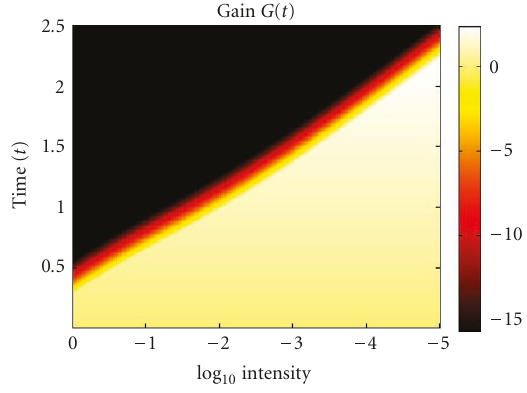
Figure 4: Photoreceptor potential : the photoreceptor potential P (1) is plotted as a function of time ( t = 0 to 250 iterations) and in- put intensity ( L ∈ { 10 0 ,10 − 1 , ... ,10 − 5 } . The photoreceptor am- plitude is color-coded (colorbar). “Convergence” occurs when the photoreceptor potential P exceeds a threshold Θ , and corresponds to the area over the diagonal line. The minimum integration time is delinated by the horizontal line at the bottom. With decreasing luminance, one observes an increase in integration time until “con- vergence” is reached (as illustrated by the red arrows pointing to the plateau). A similar increase in integration time with decreasing stimulus intensity levels is also known from the retina, and is ex- pressed as Bloch’s law of temporal integration. Bloch’s law relates the threshold for seeing a stimulus to stimulus duration (i.e., inte- gration time) and stimulus intensity: the product of stimulus dura- tion and stimulus intensity equals a constant within a so-called crit- ical time window. Bloch’s law is especially prominent for scotopic vision.